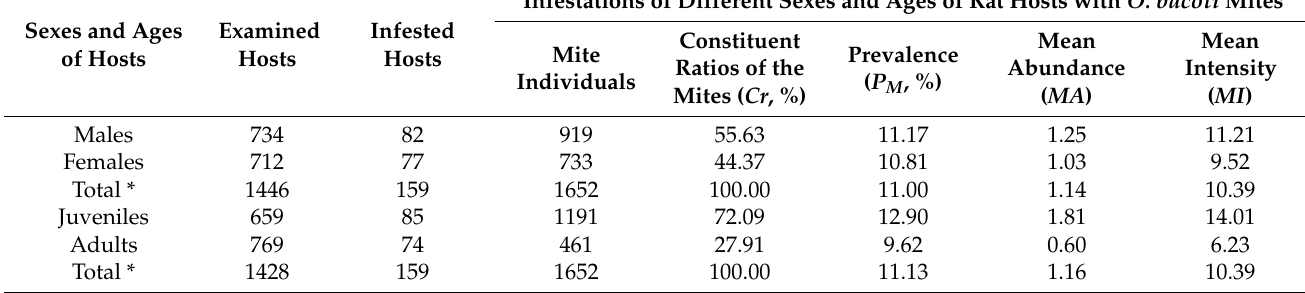
Table 3. Infestations of different sexes and ages of R. norvegicus rats with O. bacoti mites in Yunnan Province, Southwest China (1990–2015).